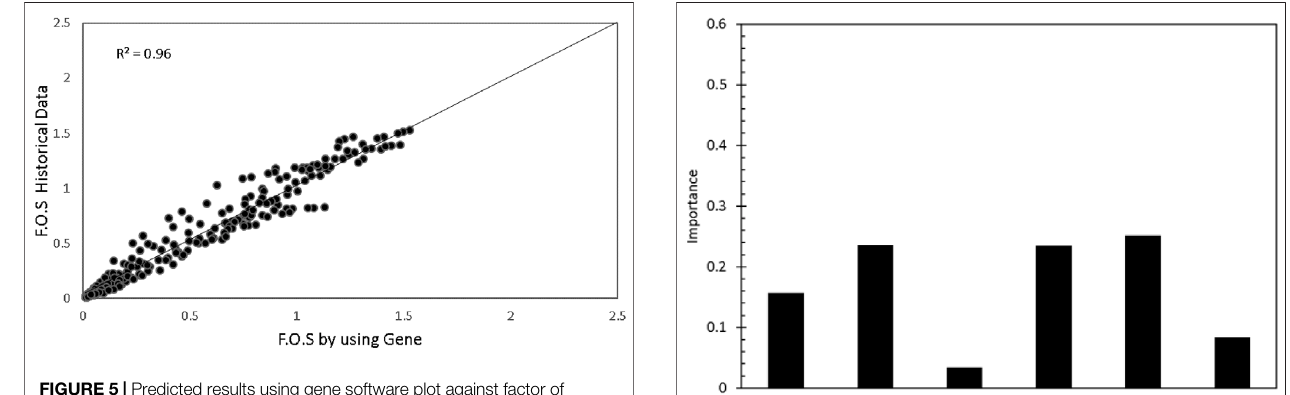
FIGURE 5 | Predicted results using gene software plot against factor of safety for measured data.